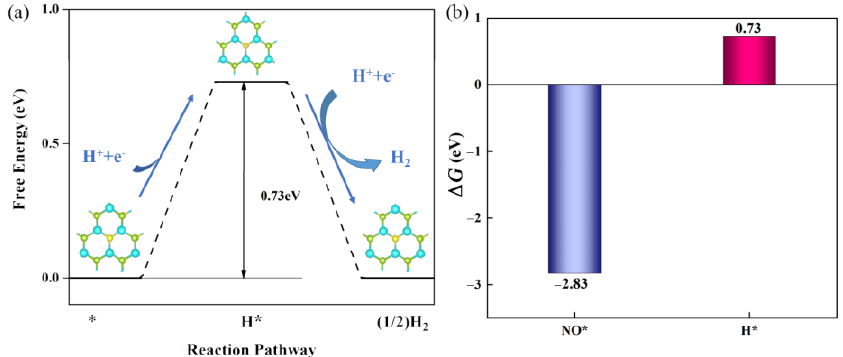
Figure 8. ( a ) Gibbs free energy diagram of HER on defective Janus WSSe monolayer. ( b ) ∆ G NO* vs. ∆ G H* of defective Janus WSSe monolayer.